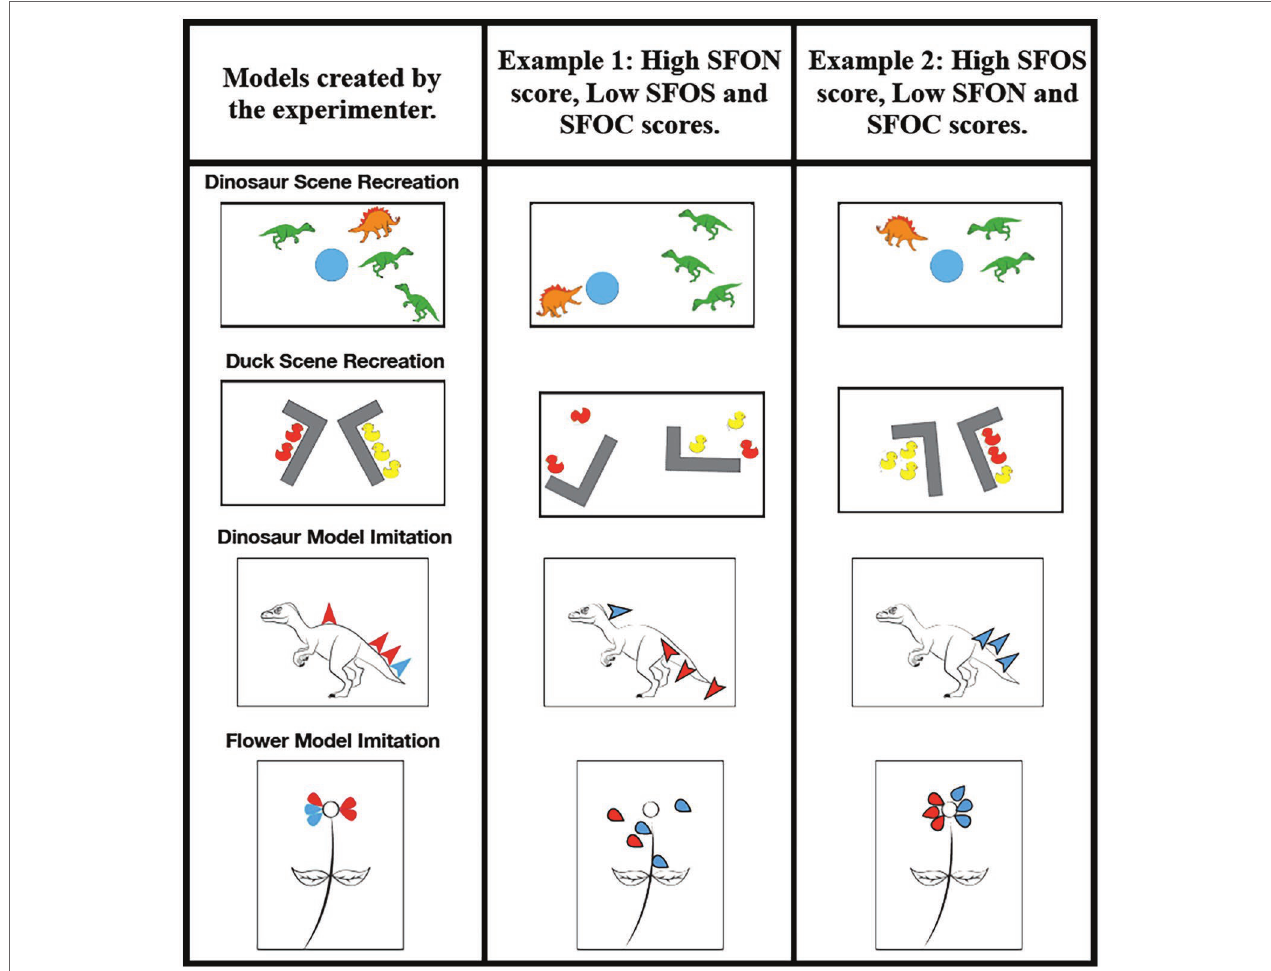
FIGURE 2 | Duck Scene Recreation trial and Dinosaur Scene Recreation trial. The dimensions of the white board were 51.6 cm × 29.0 cm. Dinosaur and Flower Stamp Modeling Task. The above images were printed on 8.5 × 11.0 in paper. For both types of tasks the experimenter modeled a version in front of the child (left column) and then gave the child the materials and asked the child to do just as the they had done. Examples of how children could have performed across the dimensions of SFON (center column), SFOS (rightmost column) and SFOC (general memory performance) are